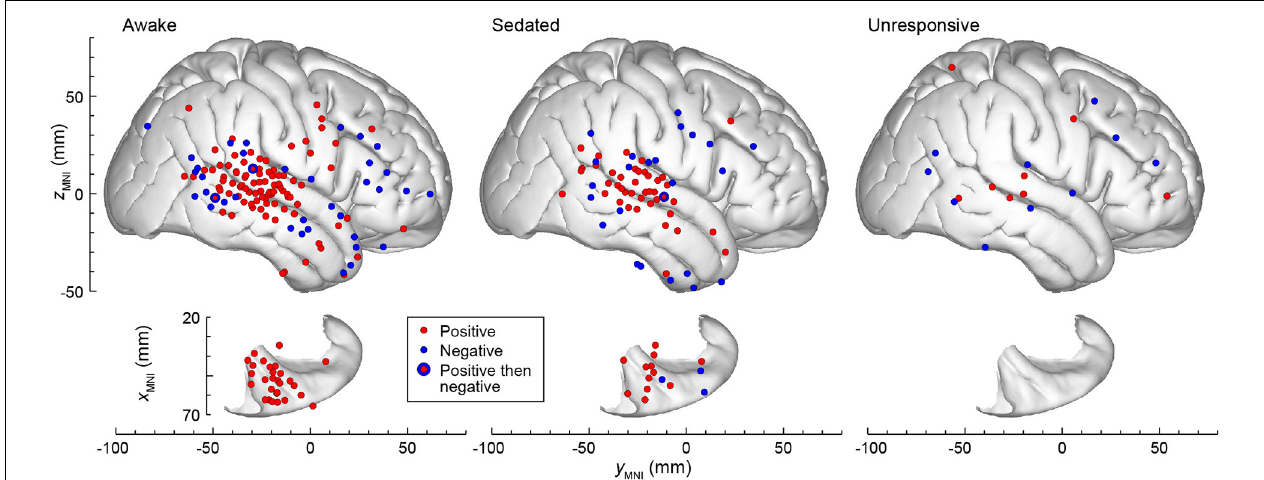
FIGURE 7 | The topography of L × G interactions across states of arousal. A summary of data from seven subjects, plotted in the MNI coordinate space and projected onto the right hemisphere of the FreeSurfer average template brain for spatial reference. Top-down views of the right superior temporal plane are plotted underneath side views of the right lateral hemispheric convexity and aligned along the y MNI axis. Sites that exhibited positive and negative L × G interactions are depicted by red and blue symbols, respectively. Note that some sites in ventral prefrontal cortex (IFG and OG) appear over anterior STG when projected onto the template brain. Sites in the STSU and STSL are projected onto the lateral hemispheric convexity and thus appear to be over either STG or